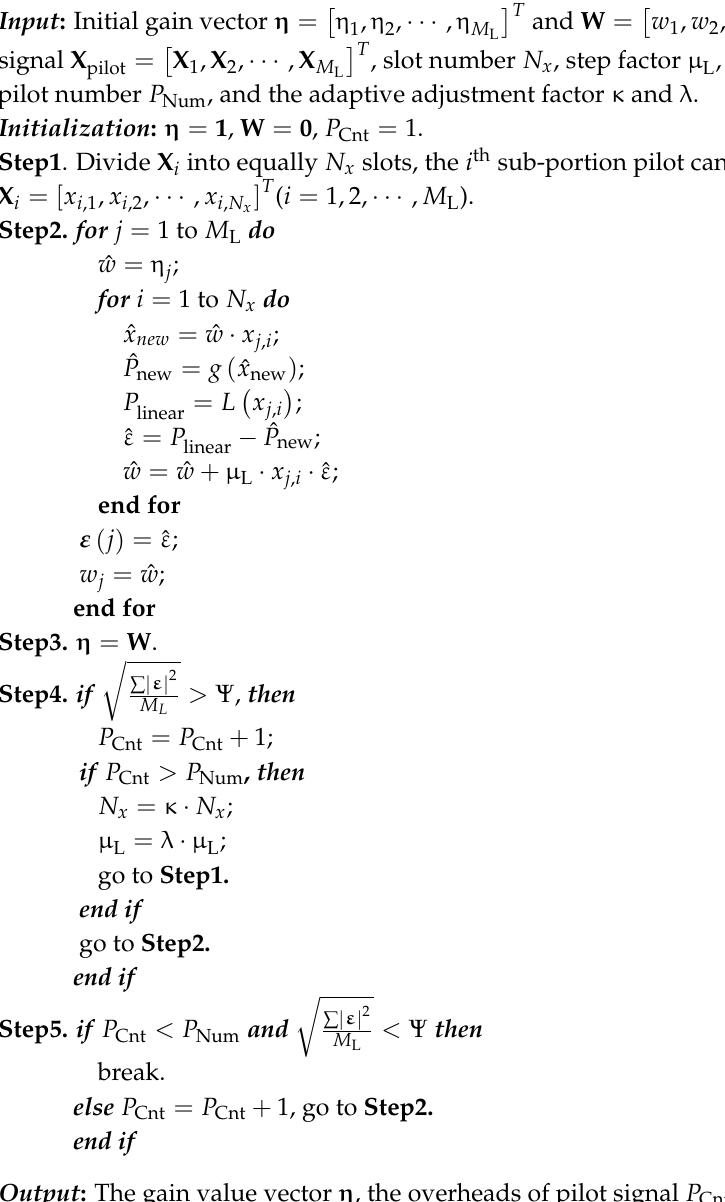
Algorithm 1: An adaptive iterative algorithm to obtain the gain values η